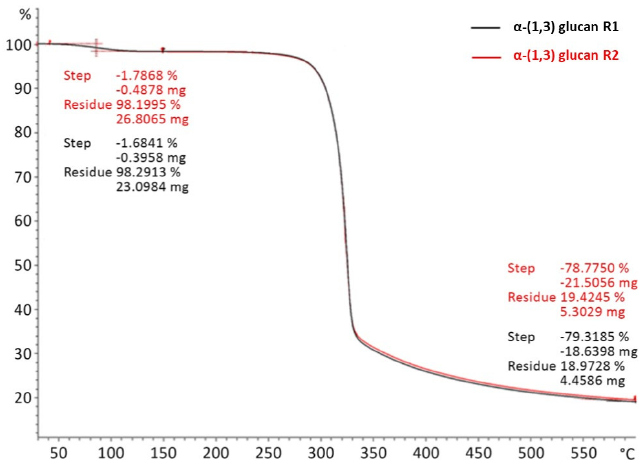
Figure 1. TGA runs on the neat α -(1,3) glucan.